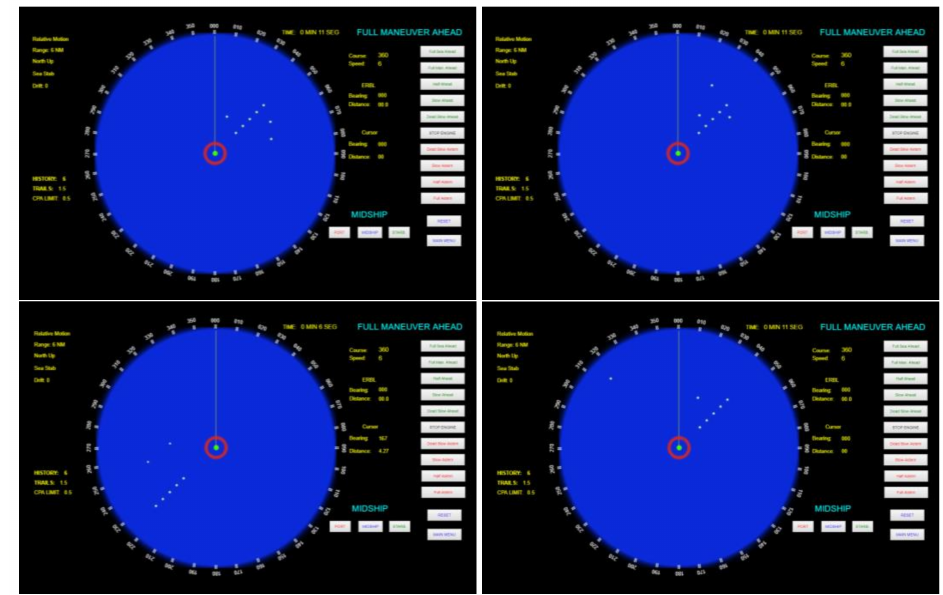
Figure 9. Examples of real positive cases where the attack command is displayed in the radar